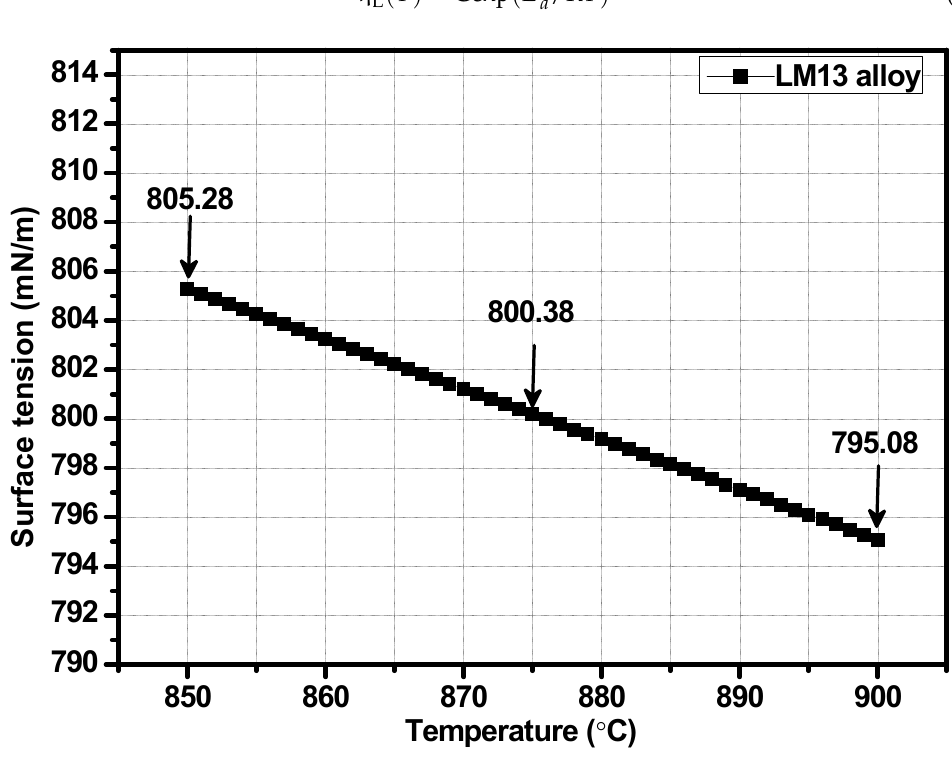
Figure 1. The e ff ect of foaming temperature on the surface tension of the LM13 alloy foams. Figure 1. The effect of foaming temperature on the surface tension of the LM13 alloy foams. The alloy type determines the coefficient factor C in the expression, where η L is the viscosity at temperature ( T ). The activation energy for a viscous flow, E a , has a connection to the gas constant, R. Figure 2 displays the temperature-dependent variation in viscosity calculated for the Al-Si12CuFe alloy. Foaming agents were added to the molten Al-Si12CuFe alloy at the correct temperature, where CaCO 3 decomposed to release CO 2 gas and bubbles were nucleated in the liquid phase. The foaming temperature increased from 850 to 900 ◦ C, increasing the diffusion rate of CaCO 3 and the nucleation rate of the gas bubbles. Many gas bubbles formed due to the high gas flow rate in the molten liquid, and the pressure inside each bubble rose as a result. Because of the low viscosity of the molten aluminum at high temperatures, the applied force of the trapped gas inside the pores will be greater than the viscosity force [20]. Figure 3 shows the macrographs of Al-Si12CuFe alloy foams produced at various foaming temperatures. This exposes the wide variation in the structural features of foam with the various foaming temperatures of the Al-Si12CuFe alloy. The structural characteristics of the foam, such as cell wall thickness, cell size average, foaming efficiency, and foam density, changed as the foaming temperature increased. The modifications in structural parameters are usually controlled by the gas bubble formation rate, the size and shape of the bubbles. The structure of the final cells can be controlled by the particle (structure, shape and size, volume fraction), gas (structure and purity), particle–surface interaction, matrix alloy composition and the temperature of the foaming, according